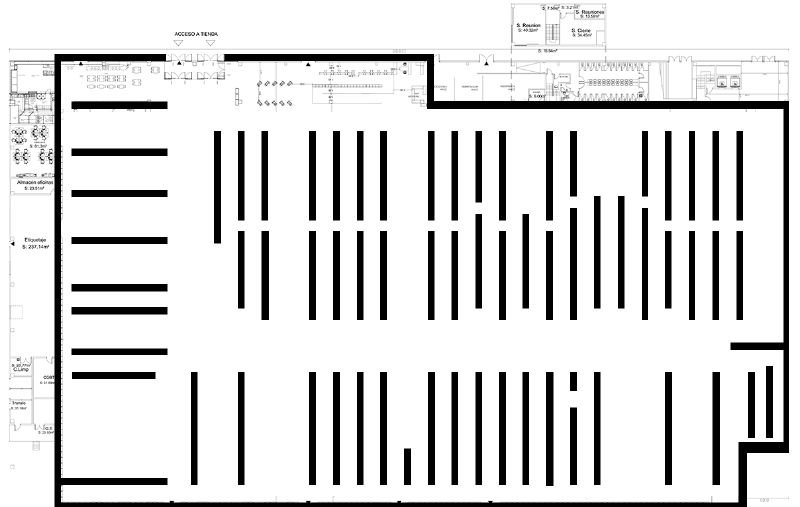
Figure 1. The shop: 138 × 90 m space with 30 different logistic